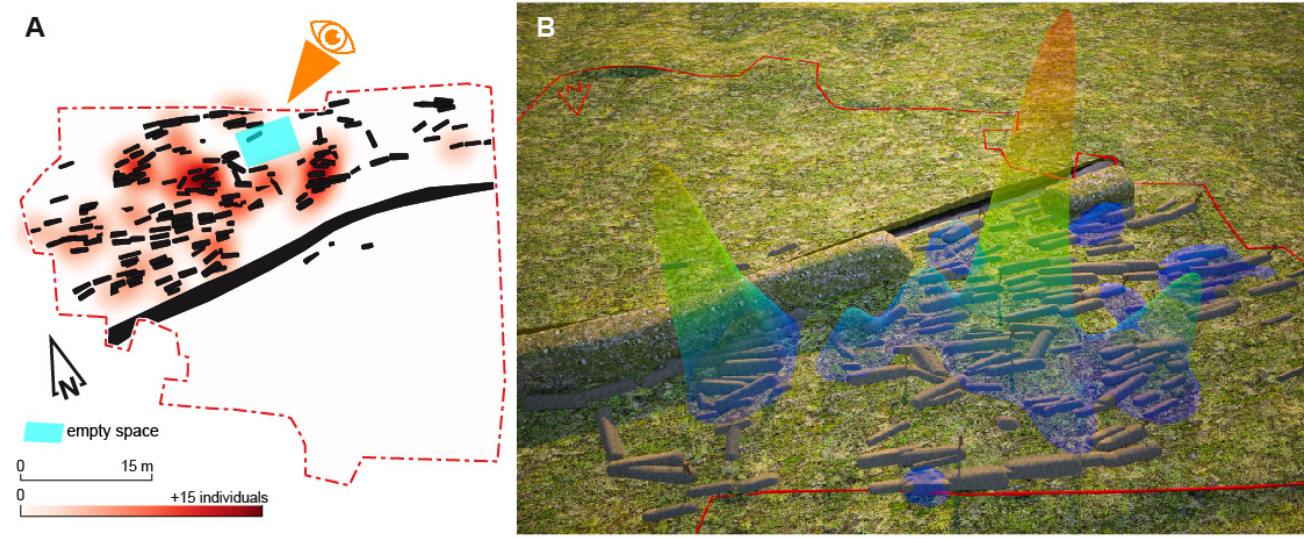
Figure 12. Heatmap for children under the age of 15. Heat map in plan ( A ) and 3D ( B ). The eye indicates the direction angle for the 3D restitution.